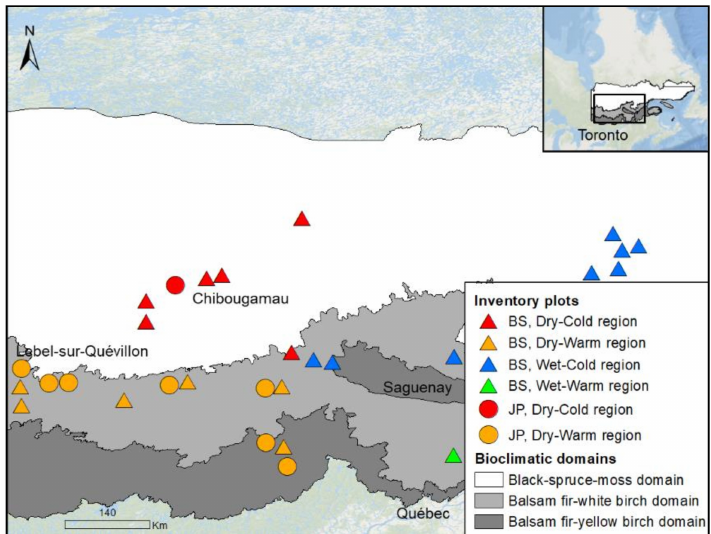
Figure 1. Location of permanent inventory plots distributed in cutblocks planted with black spruce (BS, filled triangles) and jack pine (JP, filled circles) in the balsam fir (grey areas) and spruce–moss (white area) bioclimatic domains of boreal Quebec, Canada [26]. Plots are located in four regions that were delineated based on their precipitation and temperature regimes (di ff erent coloured